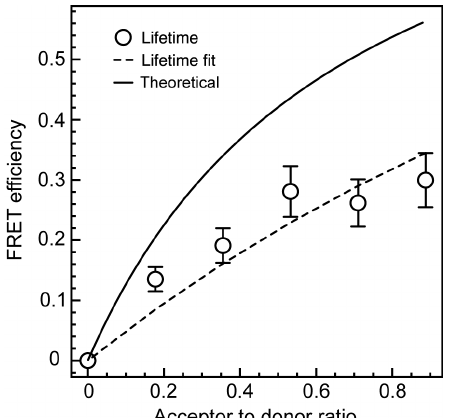
Figure 6. FRET efficiency in Ga 2 O 3 -CdSe/CdS NC conjugate (circles) determined from the DAP PL lifetime data corrected for the lifetime shortenening due to TGA binding. The experimental data were fit using Equation (5) (dashed line). Solid line is the FRET efficiency predicted by the Förster theory (Equation (3)).